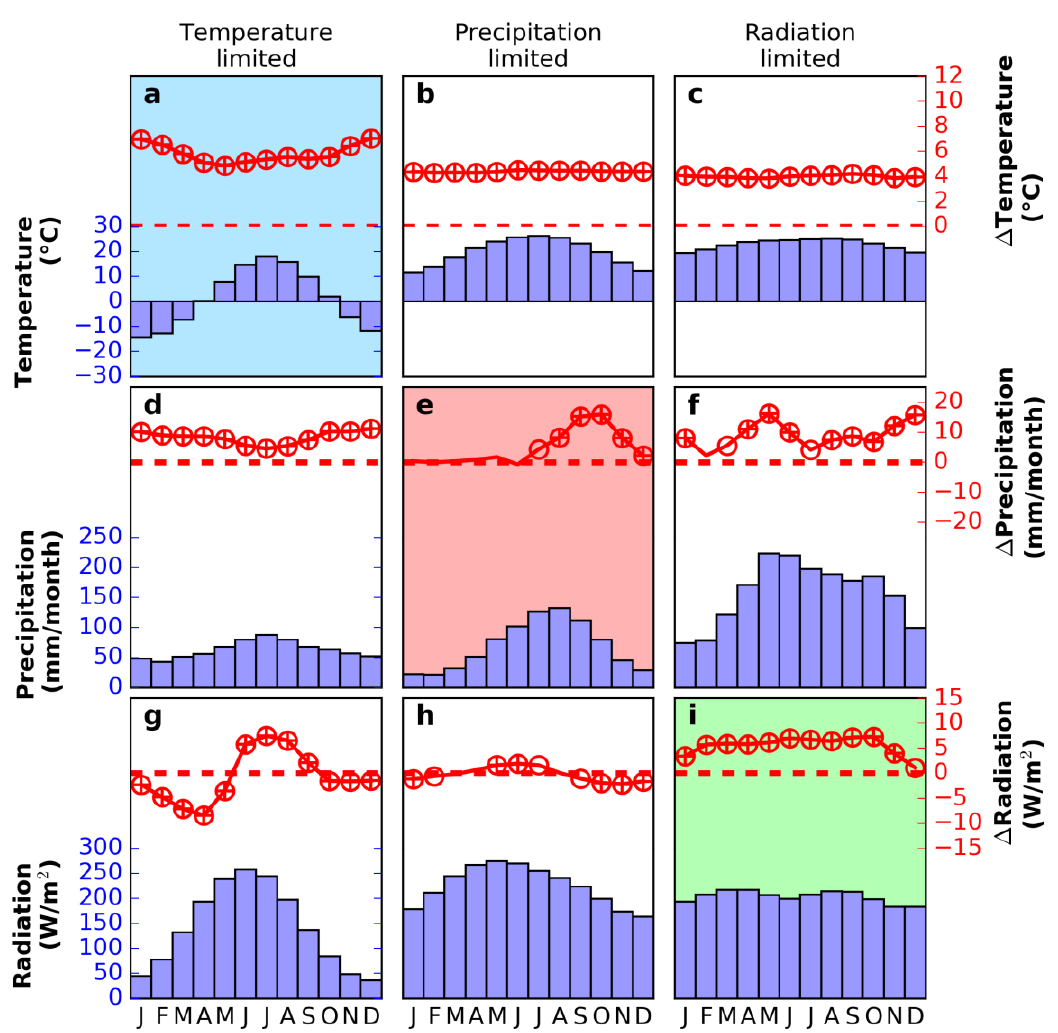
Figure 5. Easing of seasonal constraints to vegetation growth. Simulated changes in monthly climate and vegetation in the three climate-limiting regions: temperature, ( a – c ); precipitation, ( d – f ); and radiation, ( g – i ). Bars show climatological values (2006–2015), lines show ensemble mean monthly changes from Earth system models of CMIP5. Circles indicate that the trend in the 2006–2099 ensemble mean is significant at the 95% level from a Mann–Kendall trend test, while plus signs show that the Wilcoxon signed rank test is significant at the 95%. Shading is used to highlight changes in the limiting factor for each of the three regions (e.g., blue shading highlights temperature changes in the temperature-limited region).